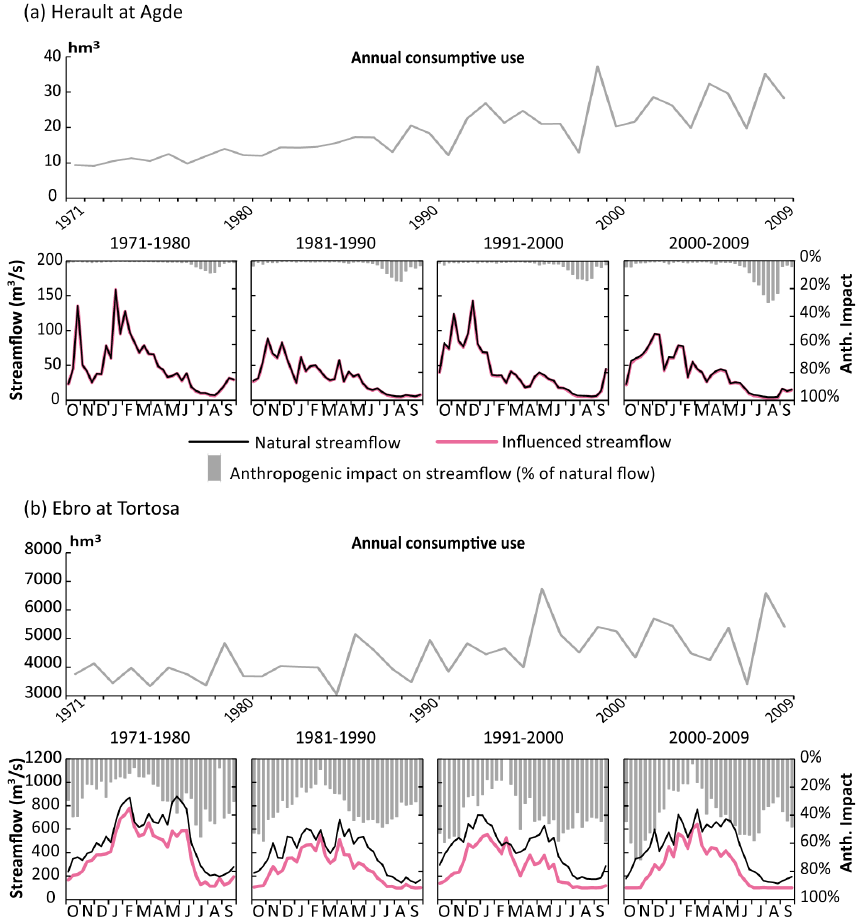
Figure 9. Comparison of natural vs. influenced simulated streamflow: anthropogenic impacts (consumptive use and water storage) on (a) the Hérault River and on (b) the Ebro